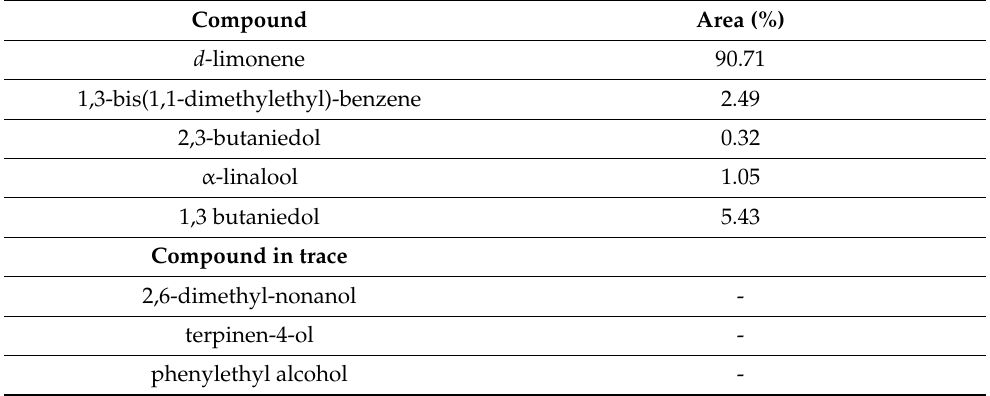
Table 6. Volatile compounds in red orange